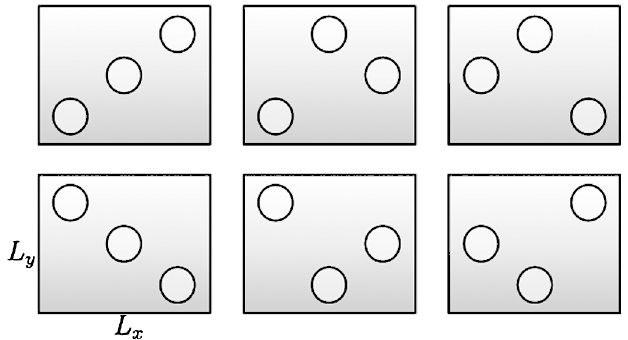
Þ . (cid:10) ; (cid:10) indicates the relative 1 2 1 indicates the position 2